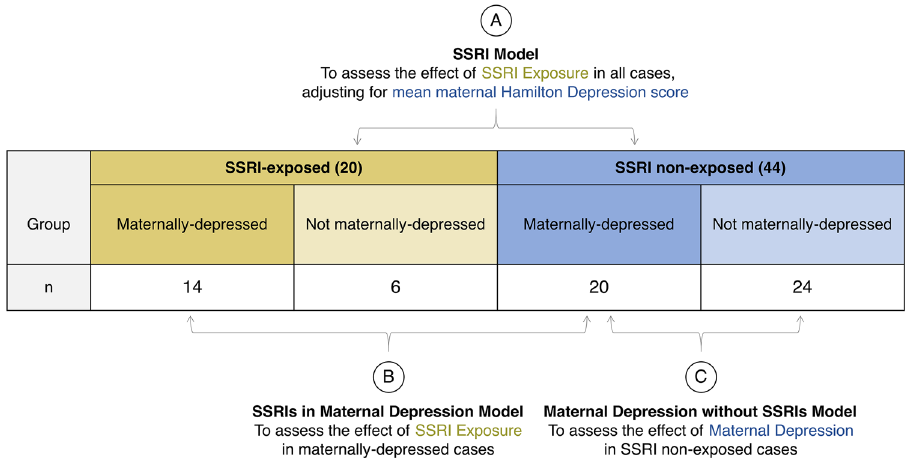
Figure 1. Comparisons for analysis of differential DNAme associated with SSRI exposure and maternal depression in the discovery cohort. ( A ) The SSRI model investigates SSRI exposure in the full cohort (n = 64), comparing SSRI-exposed (n = 20) to SSRI non-exposed (n = 44) cases, adjusting for mean maternal Hamilton Depression score across gestation. ( B ) The SSRIs in maternal depression model investigates SSRI exposure